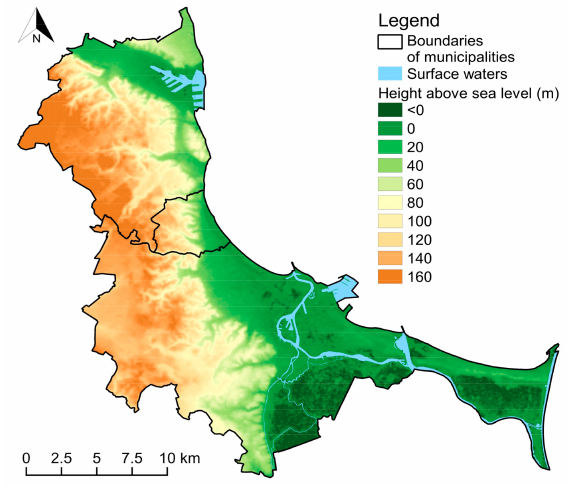
Figure 2. Relief of the core of the metropolitan area—municipalities of Gda´nsk, Gdynia, and Sopot. Source: Author’s own